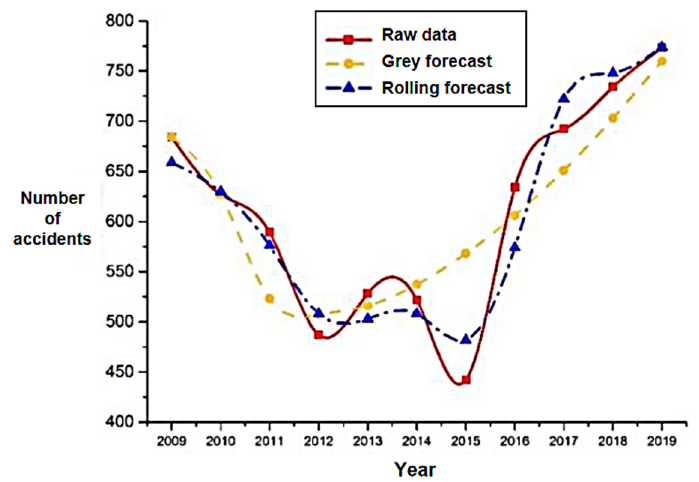
Figure 8. Annual forecast for the number of accidents.